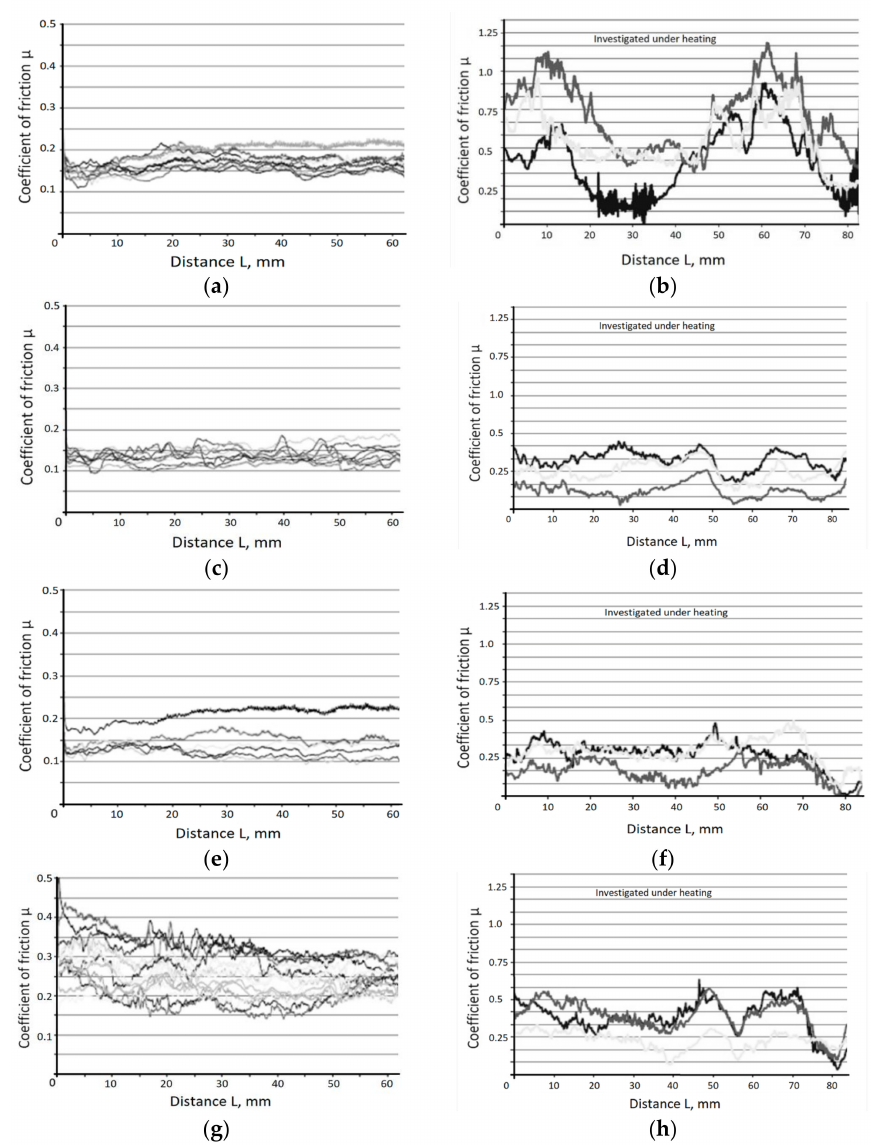
Figure 12. Dependence of the coefficient of friction of the surface of the Al 2 O 3 + TiC ceramic inserts from the friction path of hardened steel 102Cr6: ( a ) without coating at room temperature; ( b ) without coating under heating conditions; ( c ) with the DLC at room temperature; ( d ) with the DLC under heating conditions; ( e ) with the TiZrN coating at room temperature; ( f ) with the TiZrN coating under heating conditions; ( g ) with the TiCrAlN coating at room temperature; ( h ) with the TiCrAlN coating under heating